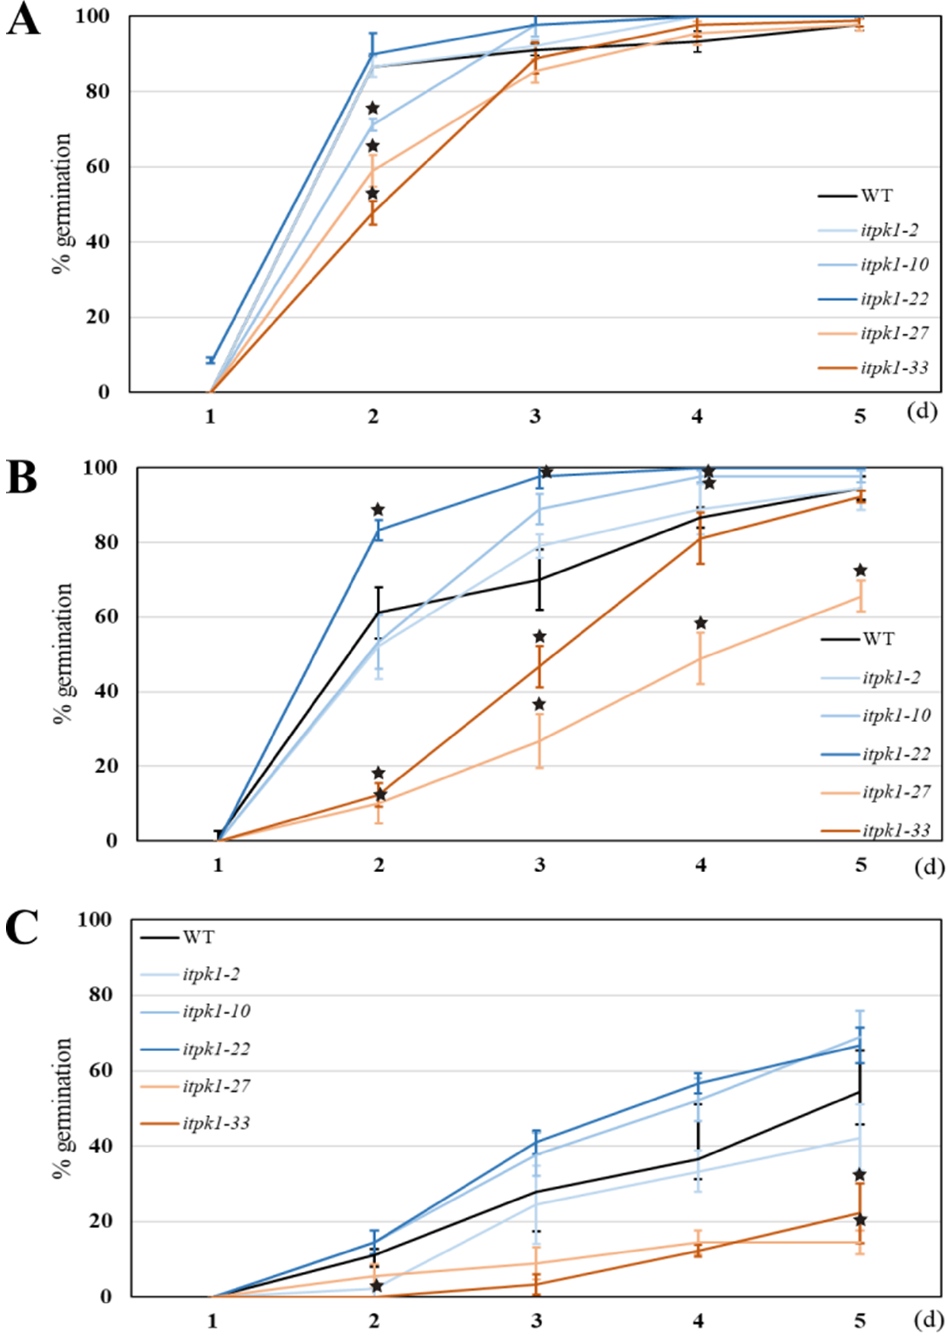
Figure 4. The effect of NaCl on germination of barley itpk1 mutants. ( A ) Control conditions without NaCl. ( B ) Grains germinated on 100 mM NaCl. ( C ) Grains germinated on 200 mM NaCl. Results for homozygous insertion mutants are displayed with differently shaded blue lines, deletion mutants with orange lines and the WT with a black line. Data represent means (n = 3 ± SD). The asterisks represent significant differences in germination percentage at p < 0.05 compared to WT based on the Aspin-Welsch unequal-variance t-test.